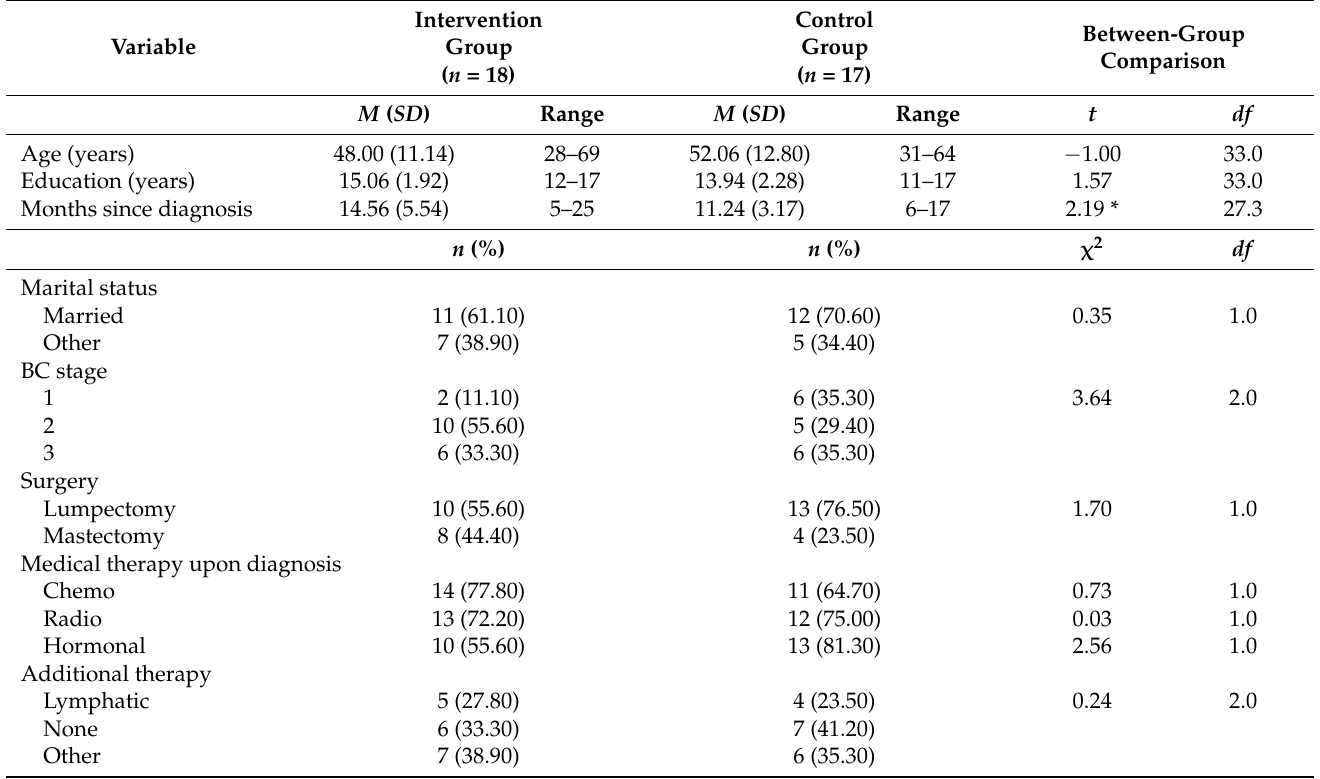
Table 1. Descriptive statistics and comparison of demographic and breast cancer clinical characteristics ( n =